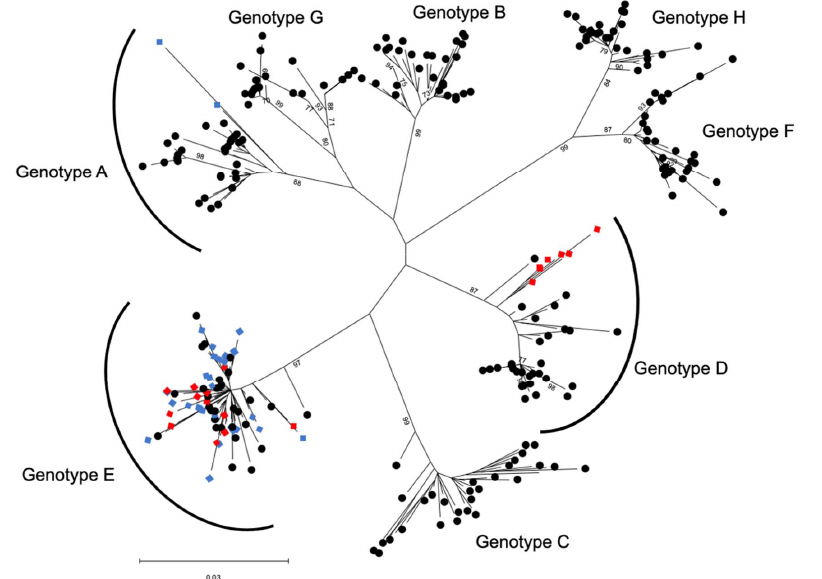
Figure 1. Phylogenetic analysis of HBV sequences based on 969 nt of the viral HBS gene compared to reference sequences for each viral genotype A–H. The phylogenetic tree was constructed using the maximum likelihood method and the Tamura–Nei model [37]. The tree with the highest log likelihood (−8124.86) is shown. This analysis involved 284 nucleotide sequences with a total of 969 positions in the final dataset. The points shown with blue diamonds represent samples collected in Bamako (Mali) and the points shown with red diamonds represent samples from Timbuktu (Mali). The black circles represent reference sequences.